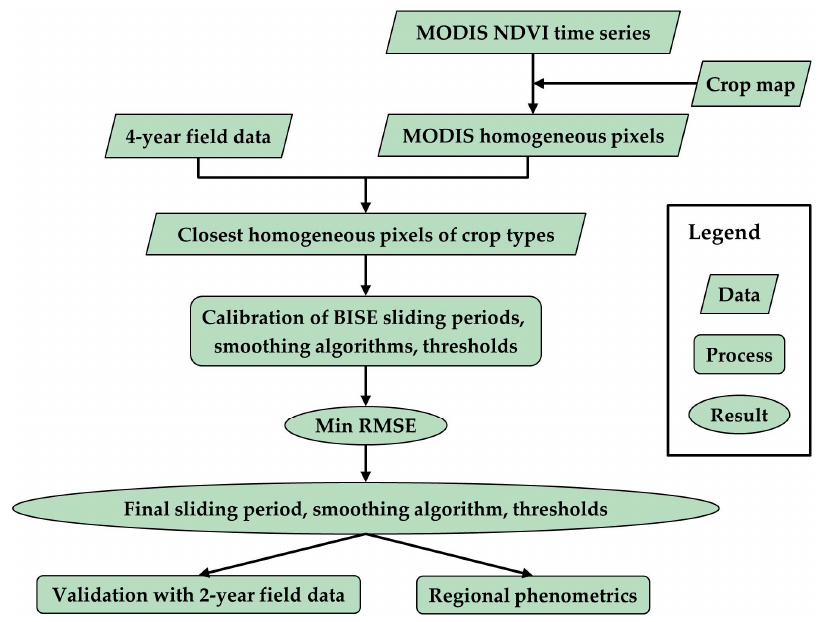
Figure 4. Processing chain (RMSE: root mean square error).